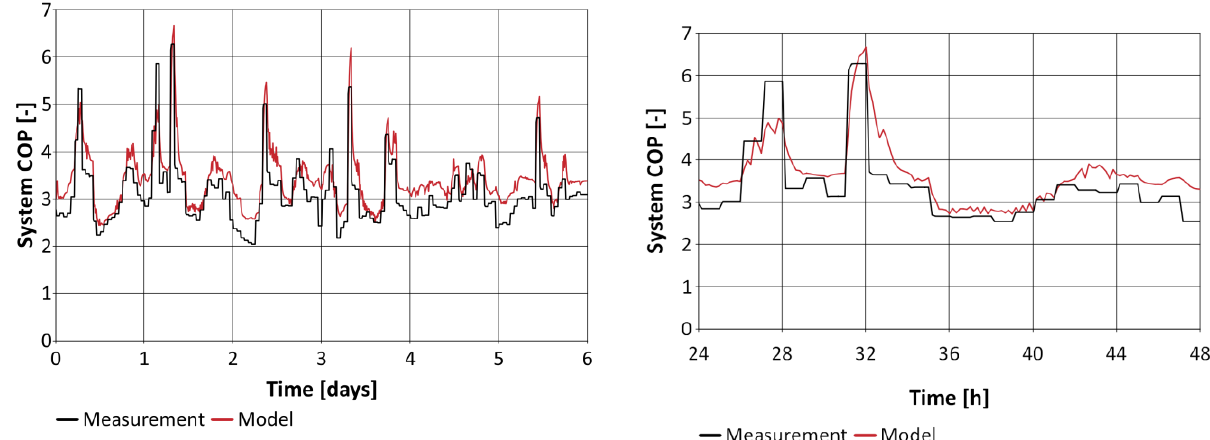
Figure 10. System COP, experimental (black) and numerical (red) for the whole validation period ( left ), and for the second day of that period ( right ).